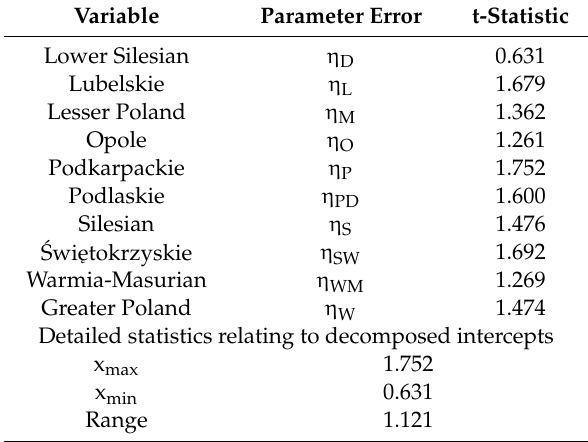
Table 2. Values of the decomposed intercepts after undoing the logarithm in imperative DLT. Variable